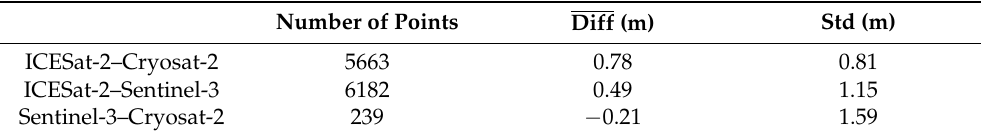
Table 1. Cross validation of the three altimeters on Cryosat-2, Sentinel-3, and ICESat-2 over Amery Front before the calving event. Number of Points Diff (m) Std (m) ICESat-2–Cryosat-2 5663 0.78 0.81 ICESat-2–Sentinel-3 6182 0.49 1.15 Sentinel-3–Cryosat-2 239 − 0.21